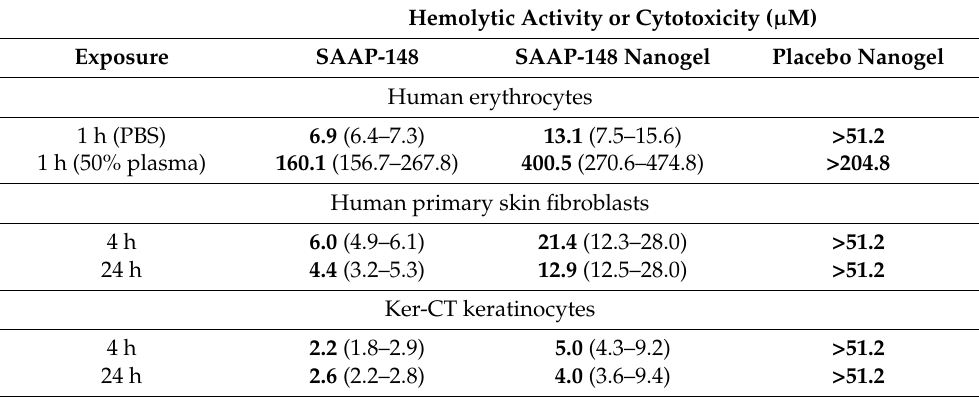
Table 4. Hemolytic and cytotoxic activities of PVA-lyophilized SAAP-148-loaded nanogels redis- persed in biorelevant medium compared to SAAP-148 and placebo